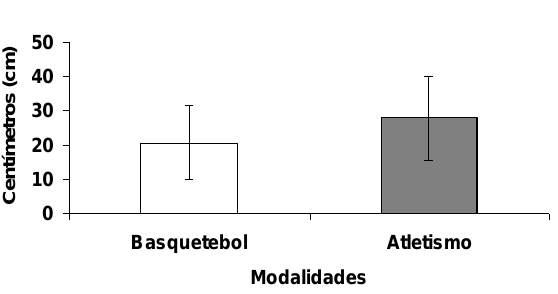
Figura 2. Média e desvios padrão dos escores do teste de percepção cinestésica. TESTE DE PERCEPÇÃO CINESTÉSICA